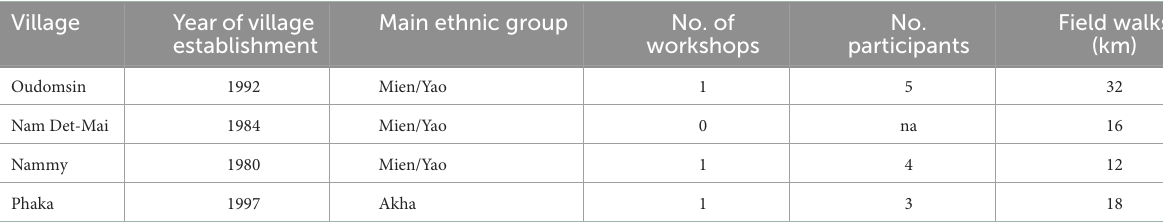
TABLE 2 Overview of participatory mapping workshops and field